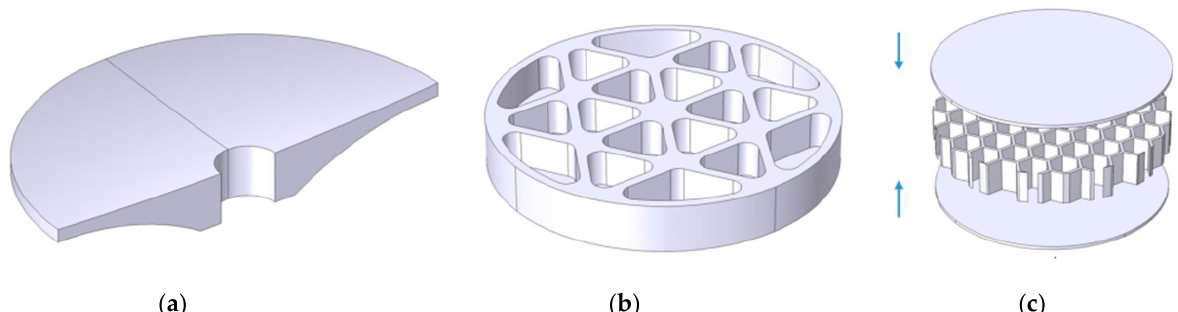
Figure 2. ( a ) Example of an arched mirror; ( b ) Example of an open-back mirror; ( c ) Example of a sandwich mirror [19].